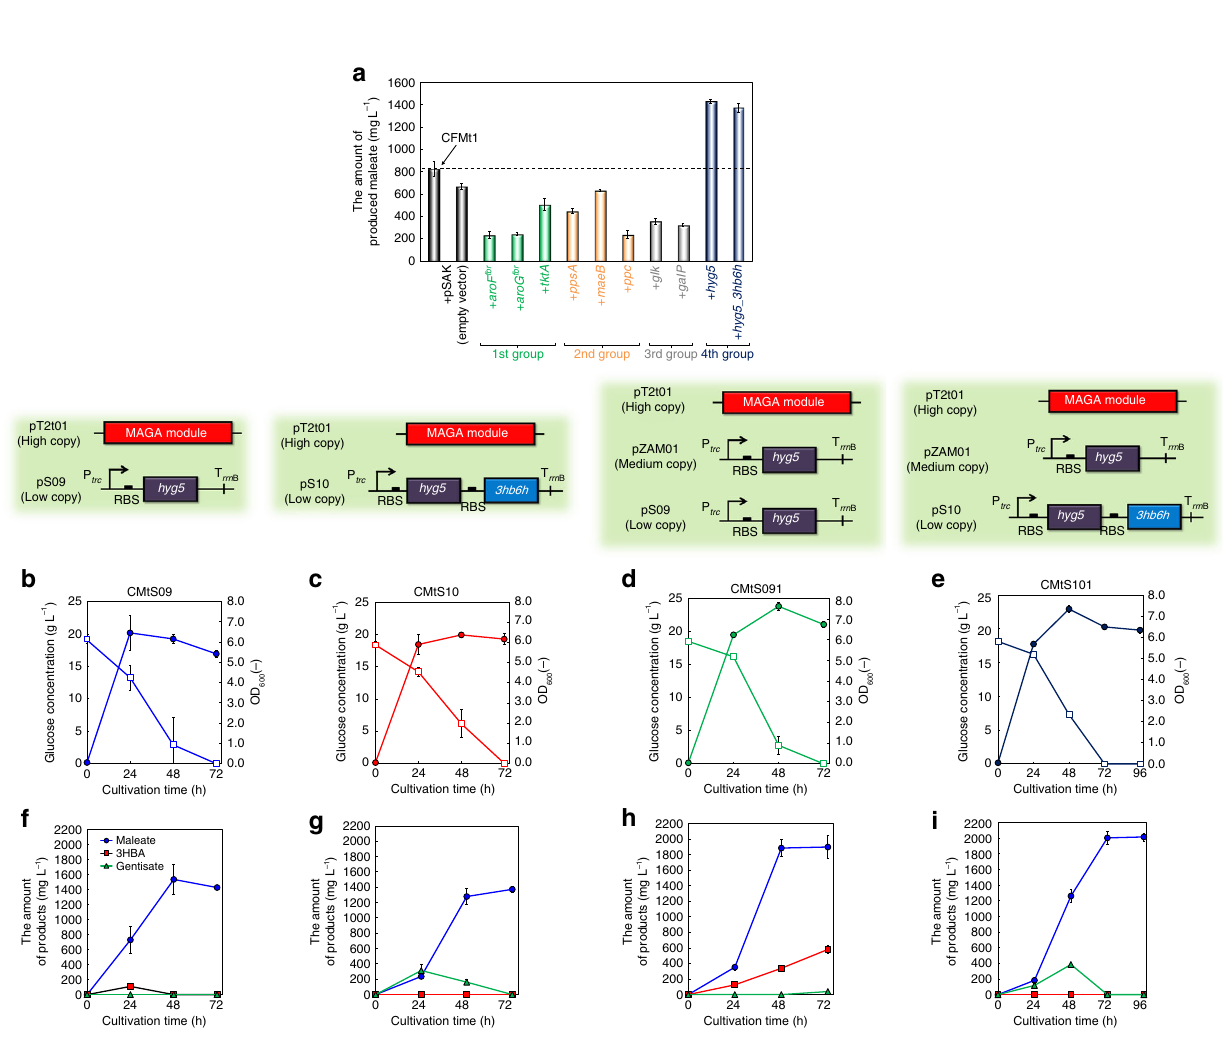
Fig. 7 Improvement of rate limiting steps in the constructed pathway of maleate production. a The amount of maleate produced by each candidate transformant after 48 h of cultivation. Time courses of b – e the bacterial growth ( fi lled symbols) and glucose concentration (open symbols), and f – i produced maleate (circles), 3HBA (squares), and gentisate (triangles) in the cultures of CMtS09, CMtS10, CMtS091 and CMtS101. Data are presented as the mean ± standard deviation of three independent experiments ( n = 3)